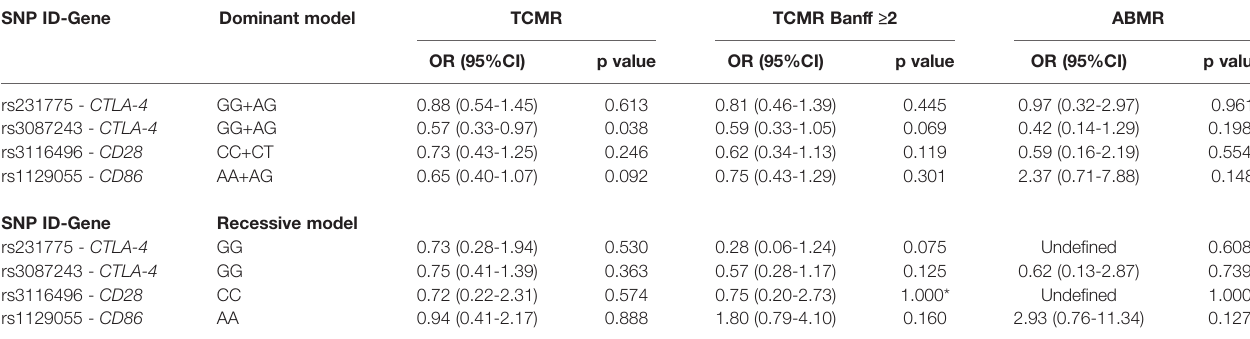
TABLE 3 | Univariate analysis for rejection in patients with no Thymoglobulin induction therapy.